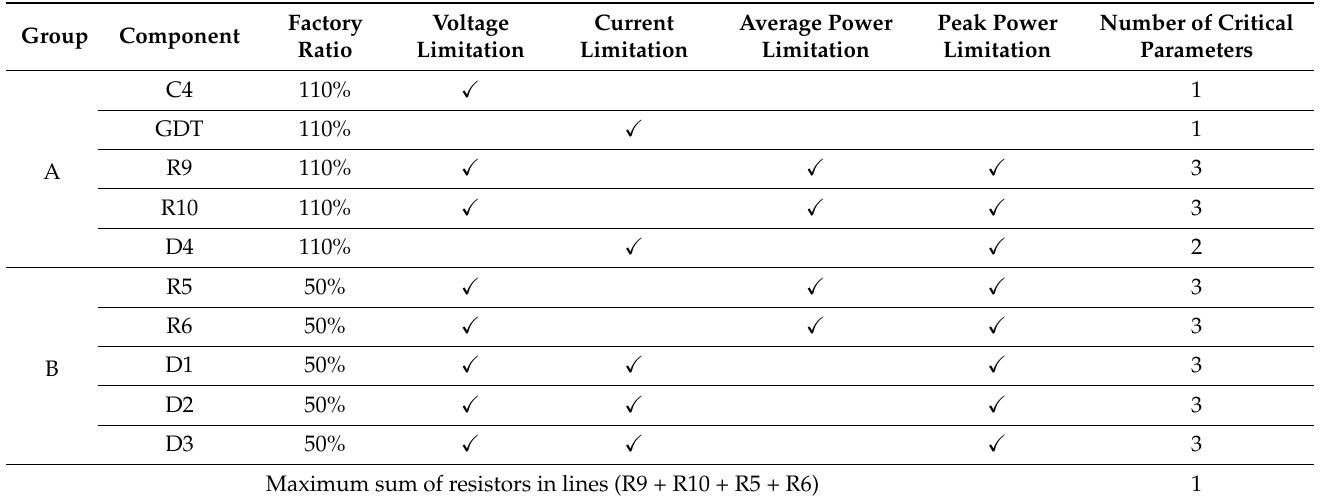
Table 2. Calculation of penalty factor ( α ).